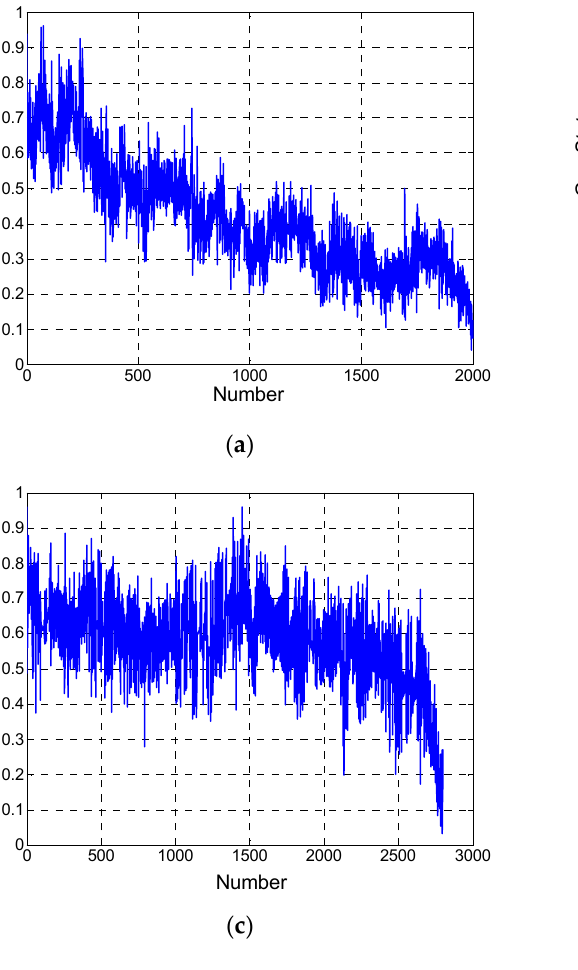
Figure 3. Gap states reflected autonomous EDM process. ( a ) Unstable spark discharge; ( b ) stable spark discharge; ( c ) stable arc discharge; ( d )transient arc discharge.